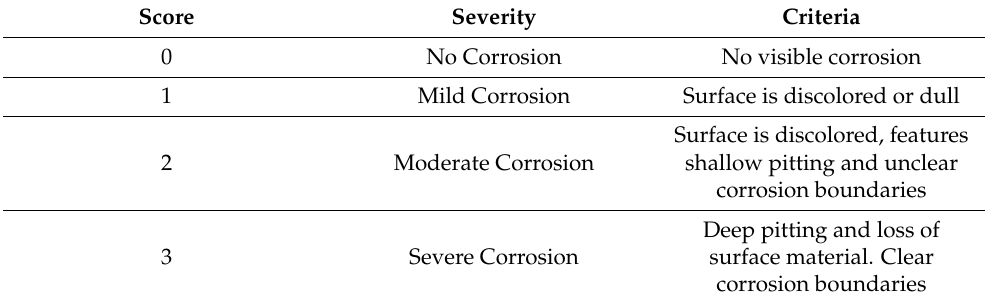
Table 2. Modified Goldberg severity scale utilised to qualitatively grade the surface corrosion